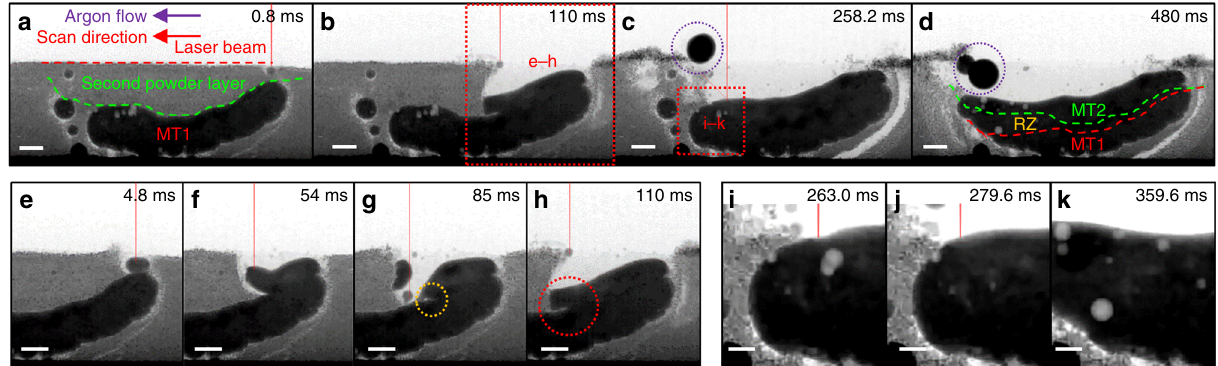
Fig. 3 Time-series radiographs acquired during LAM of an Invar 36 s layer melt track (MT2) under P = 209 W, v = 13 mm s − 1 and LED = 16.1 J mm − 1 , see details in Supplementary Movie 5. Snapshots of MT2 at various stages of LAM: a formation of a molten pool on the second powder layer; b the growth of MT2 via wetting on MT1; c MT2 undergoes laser-re-melting, where RZ indicates the laser re-melting zone; d , MT2 completely solidi fi es. ( c-d ) The large droplet spatter (purple dotted circle) failed to eject from the powder bed. Other key phenomena involved during molten pool wetting: e re-melting of MT1; f an extension of MT2 before wetting on MT1; g entrapment of gas bubble (see yellow dotted circles); and h thin powder layer (see red dotted circles). Three pore evolution mechanisms induced by laser re-melting: i pore coalescence; j pore dissolution; and k pore dispersion into smaller